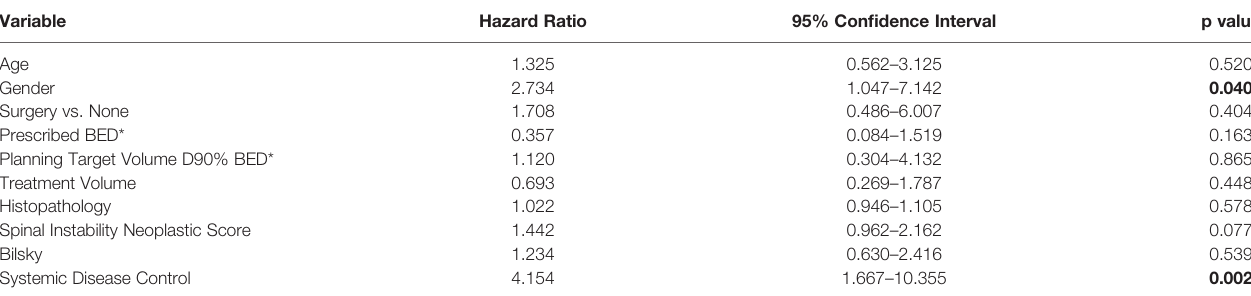
TABLE 3 | Multivariate analysis examining for variables associated with improved local control in patients with ≥ 3 contiguous treated levels using a proportional hazards model. Variable